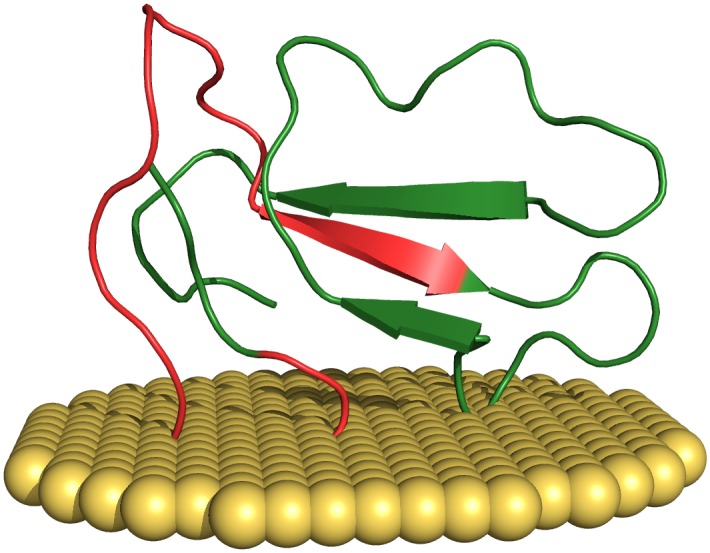
Interactions between CTXs and biologic membranes.Three-dimensional structure of the S-type CTX-1 (P60304) from Naja atra (Chinese cobra). The penetration of the membrane (colored in yellow) involves the tip of loop I only. The initial portion of the NCPs generating stretch (colored in red) appear mainly involved in this interaction. Visualized using the PyMOL Molecular Graphics System, Version 1.8 Schrödinger, LLC.